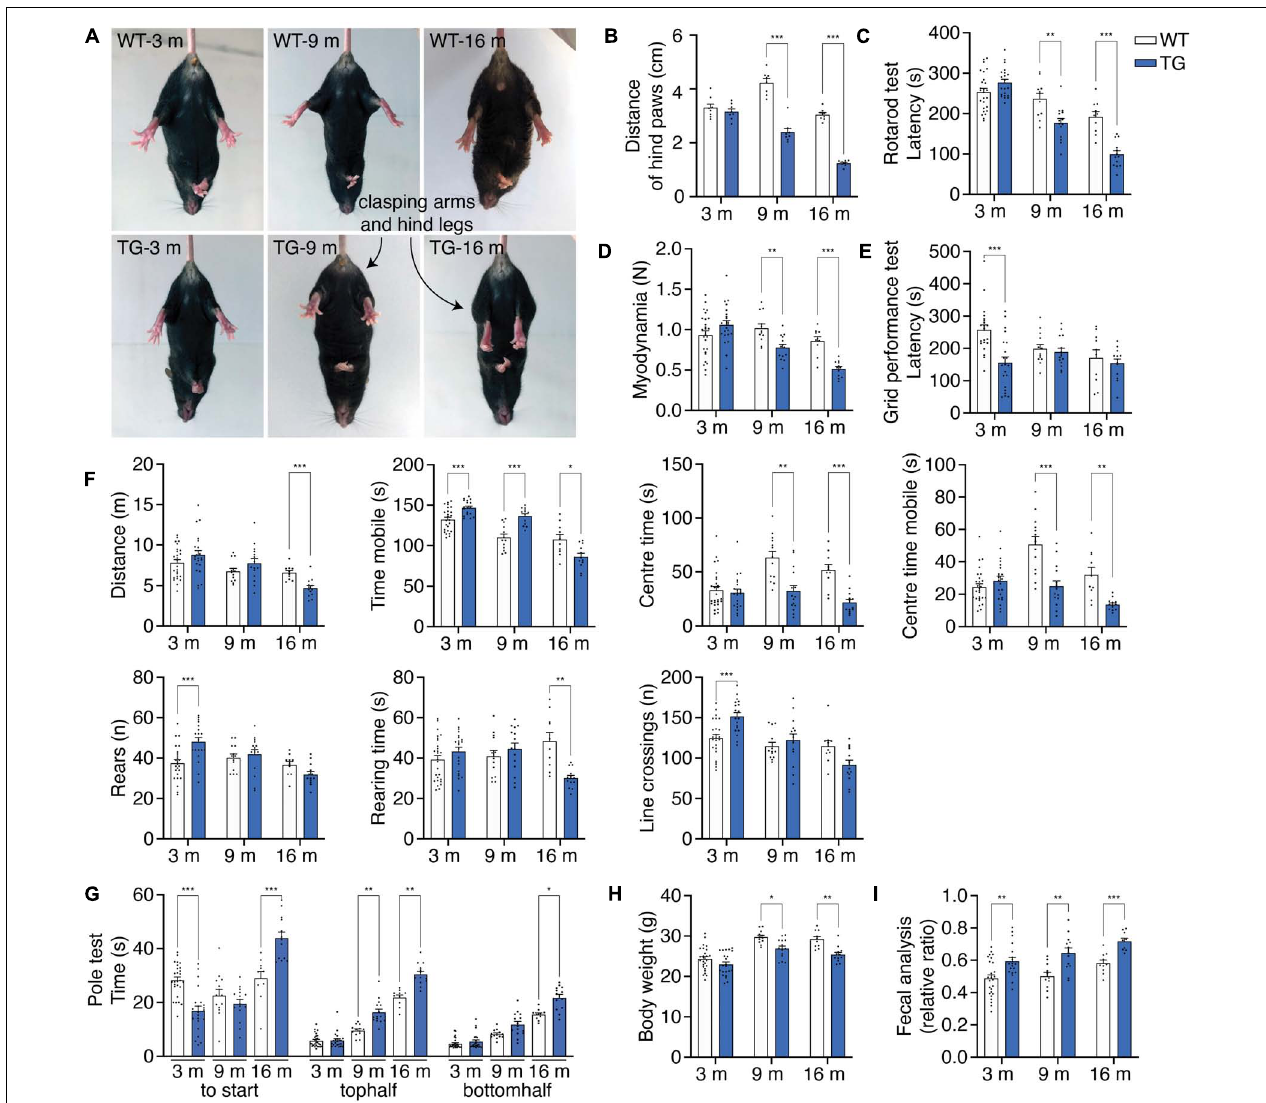
FIGURE 5 | N103 mice show behavioral impairment, weight loss, and constipation. (A) Representative images of tail suspension test presenting clasping arms and legs of N103 mice. (B) Quantification analysis of the mean distances of the hind paws of WT and N103 mice in (A) . Data are mean ± s.e.m.; n = 8 mice per group. (C) Rotarod test of WT and N103 mice. (D) Myodynamia test of WT mice and N103 mice. (E) Grid performance test of WT littermates and N103 mice. (F) Open field test assessing the locomotion behavior of control group and N103 mice. (G) Pole test revealing the exploration intention and motor function of WT mice and N103 mice. (H) Bodyweight of WT mice and N103 mice at different ages. (I) Fecal analysis showing the excremental water content of the control and N103 mice. ** P < 0.01 and *** P < 0.001 by Mann–Whitney U test. (C–I) Data are mean ± s.e.m.; n = 27 WT mice of 3 months, n = 13 WT mice of 9 months, n = 10 WT mice of 16 months, n = 22 N103 mice of 3 months, n = 15 N103 mice of 9 months, and n = 13 N103 mice of 16 months. (B–H) * P < 0.05, ** P < 0.01, and *** P < 0.001 by two-way ANOVA and Bonferroni’s multiple